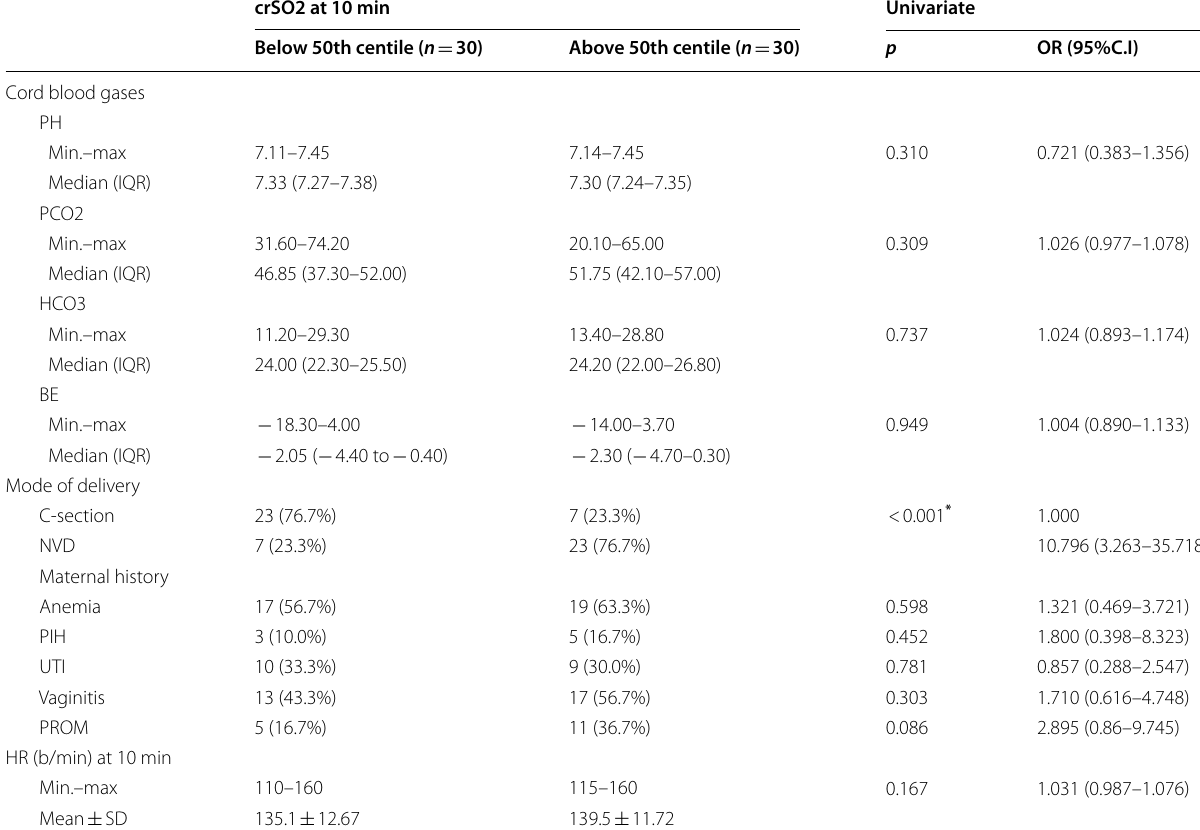
IQR interquartile range, SD standard deviation, OR odd’s ratio, C.I confidence interval, LL lower limit, UL upper limit, p p value for Odd`s ratio for comparing between the studied groups, NVD normal vaginal delivery, UTI urinary tract infection, PIH pregnancy-induced hypertension, HR heart rate at 10 min, PROM premature rupture of membranes * Statistically significant at p ≤